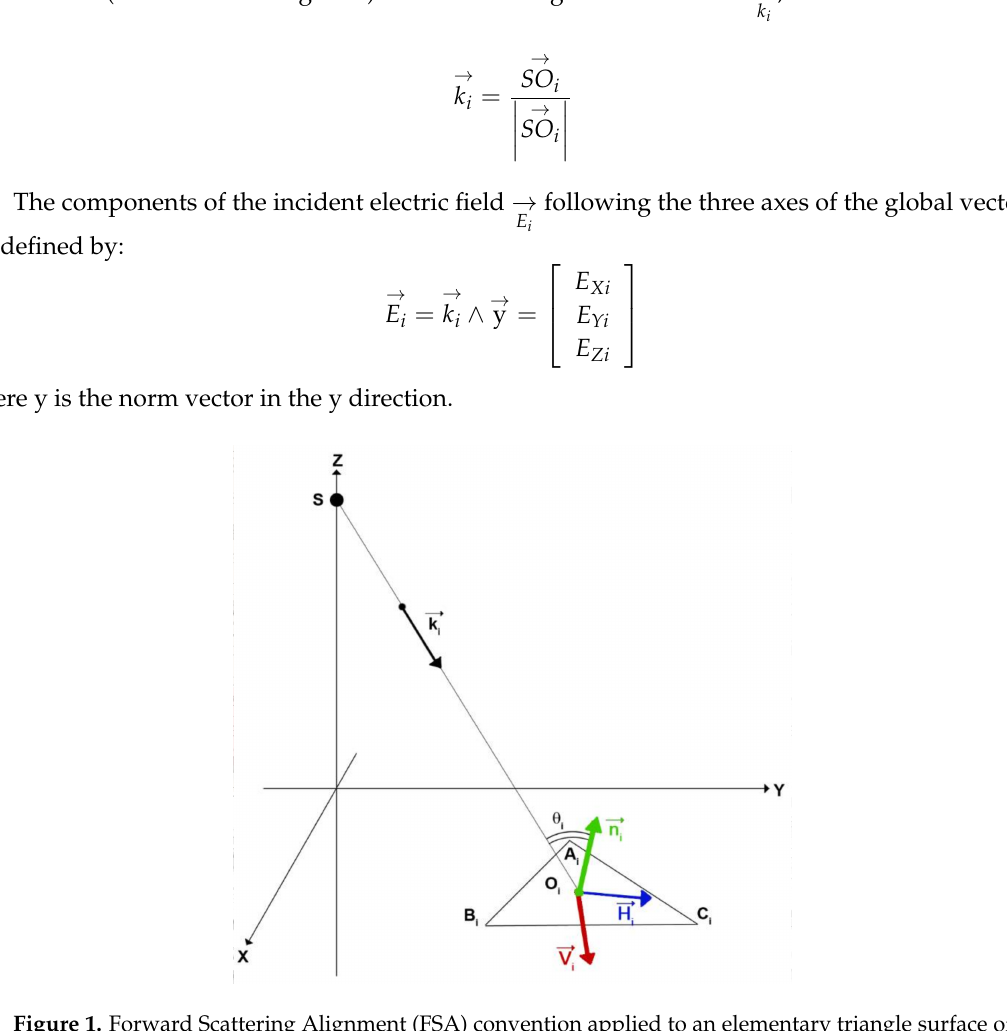
Figure 1. Forward Scattering Alignment (FSA) convention applied to an elementary triangle surface of the meshgrid used in the